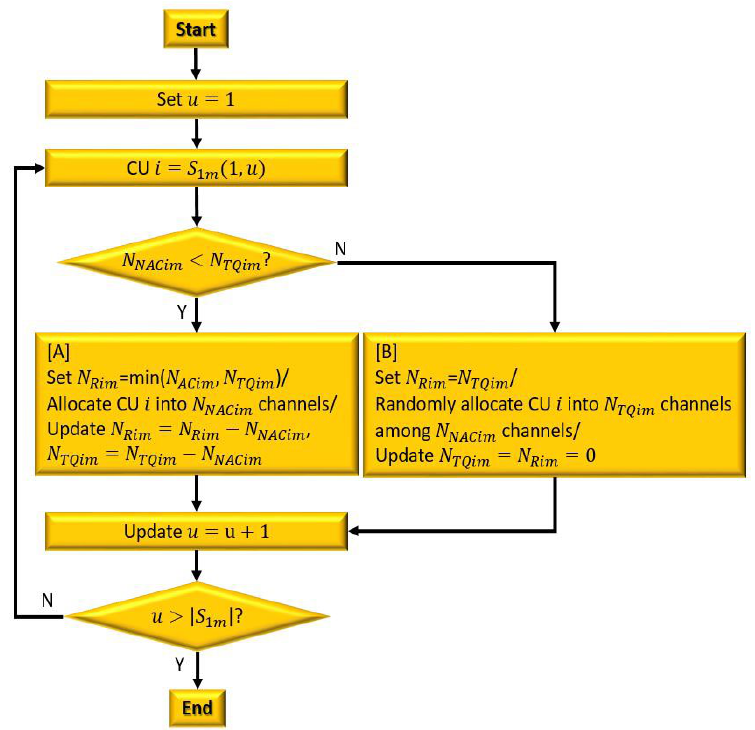
Figure 7. A flow chart of NAC allocation.